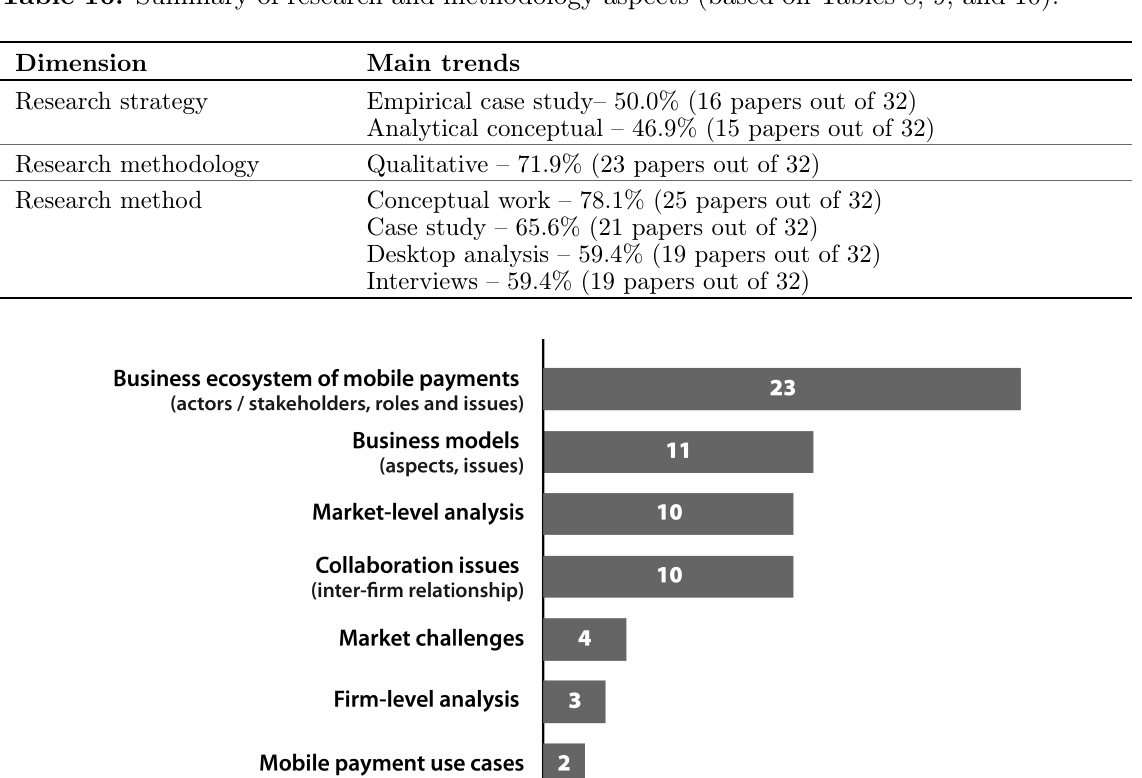
Table 16. Summary of research and methodology aspects (based on Tables 8, 9, and 10).